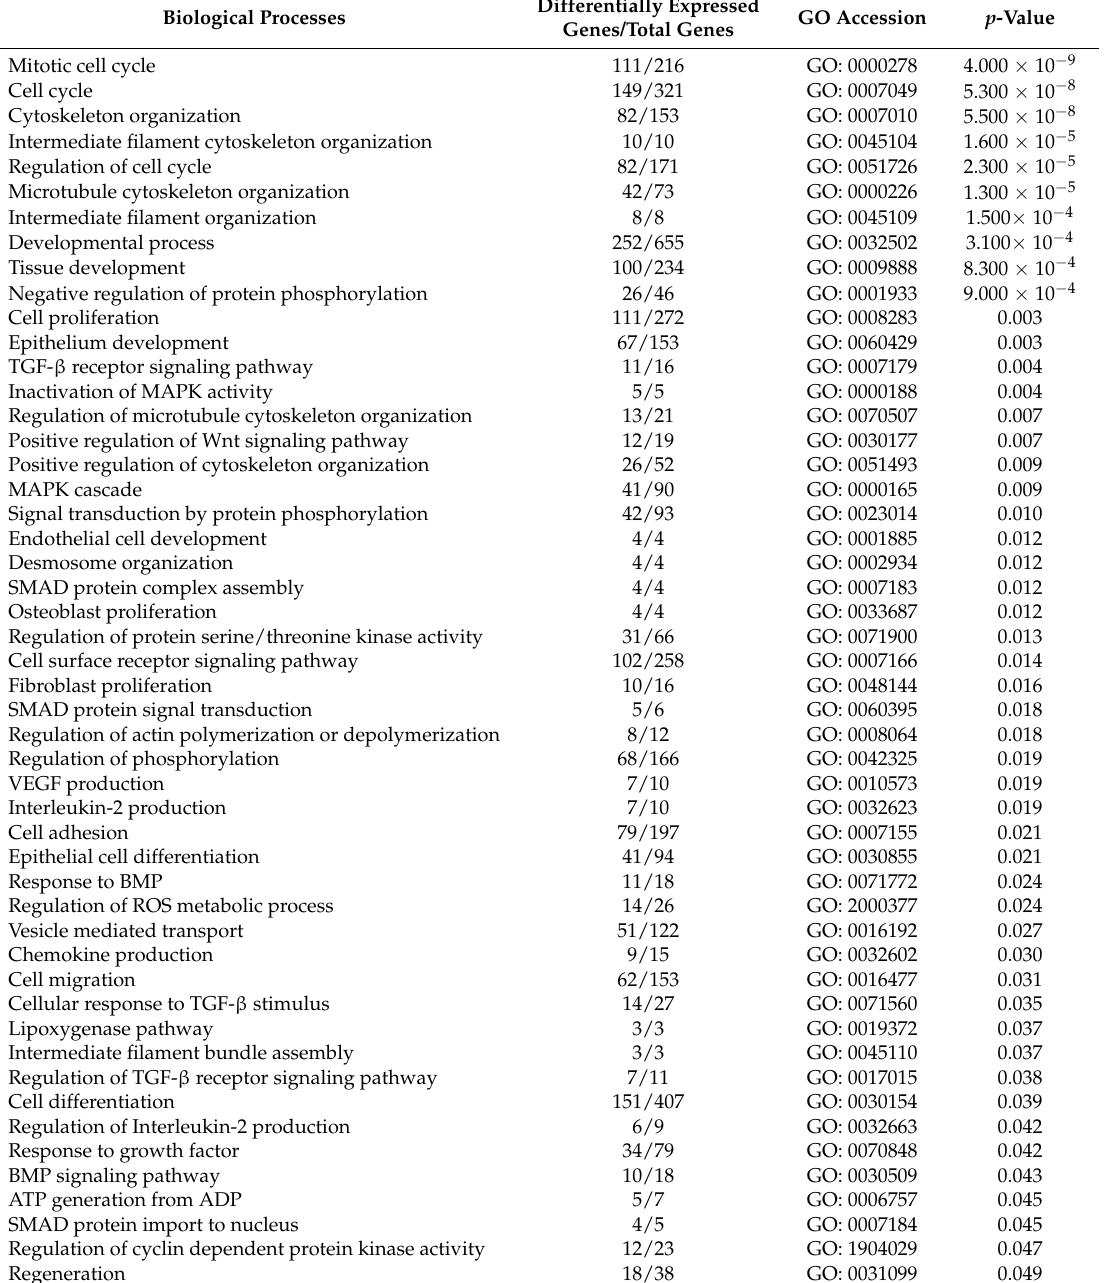
Table 2. Biological processes significantly impacted during BMP7 stimulation in hTCEpi